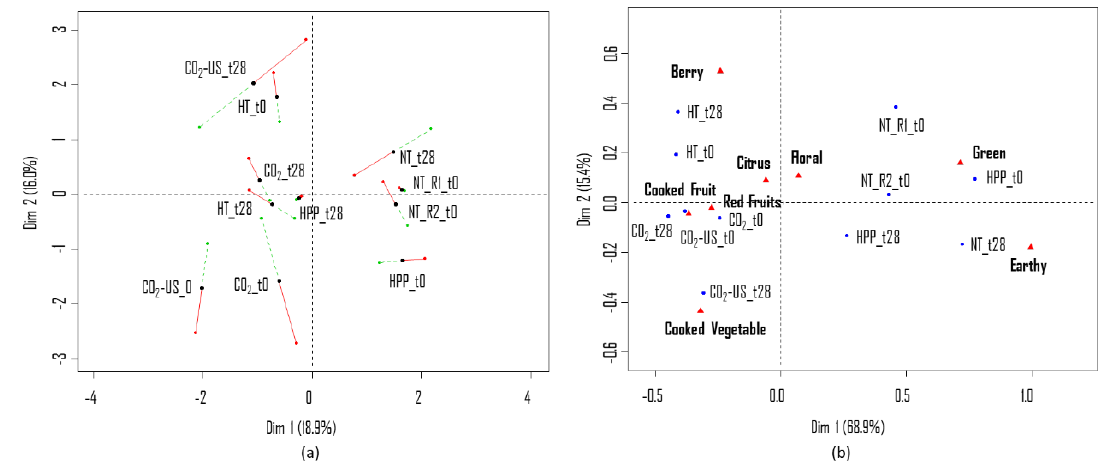
Figure 4. ( a ) MFA individual factor map (first two dimensions) based on odor perception with superimposed partial points from the two evaluation sessions (S1: red dot and S2: green dot) for each type of juice considered (NT, HT, HPP, CO 2 , CO 2 -US) at the beginning (t 0 ) and end (t 28 ) of storage at 4 °C. ( b ) CA bi-plot obtained from the CATA questionnaire based on odor perception.